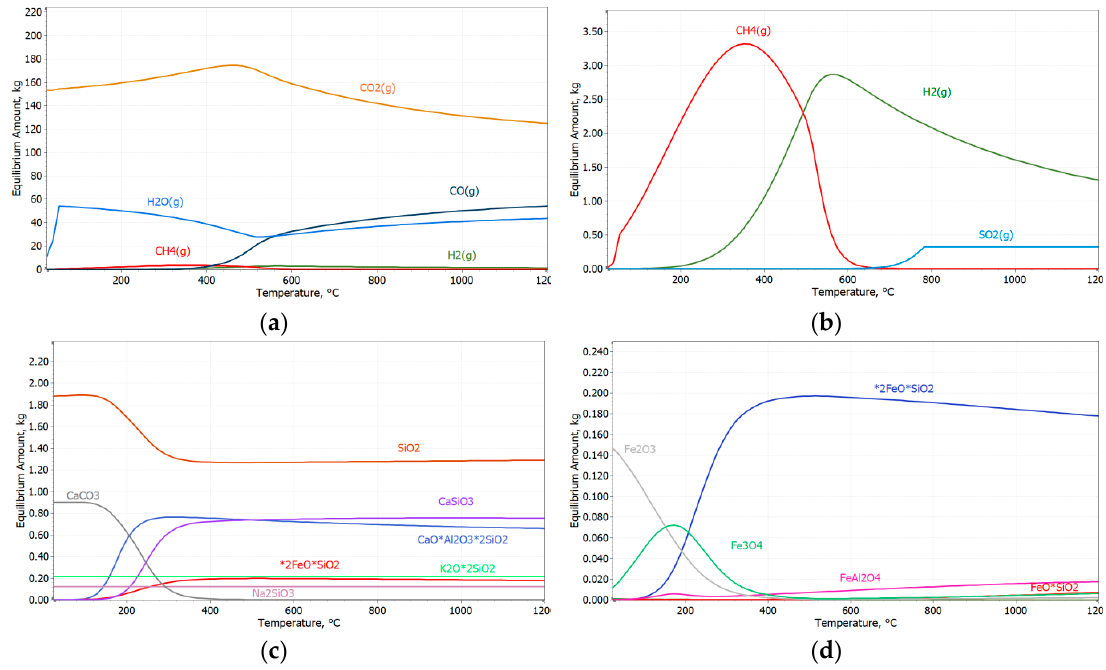
Figure 6. Gibbs equilibrium diagrams of lignin combustion (calculation for 100 kg of fuel). ( a ) Results for majority gas compounds; ( b ) results for minority gas compounds; ( c ) results for majority solid compounds; and ( d ) results for minority solid compounds.